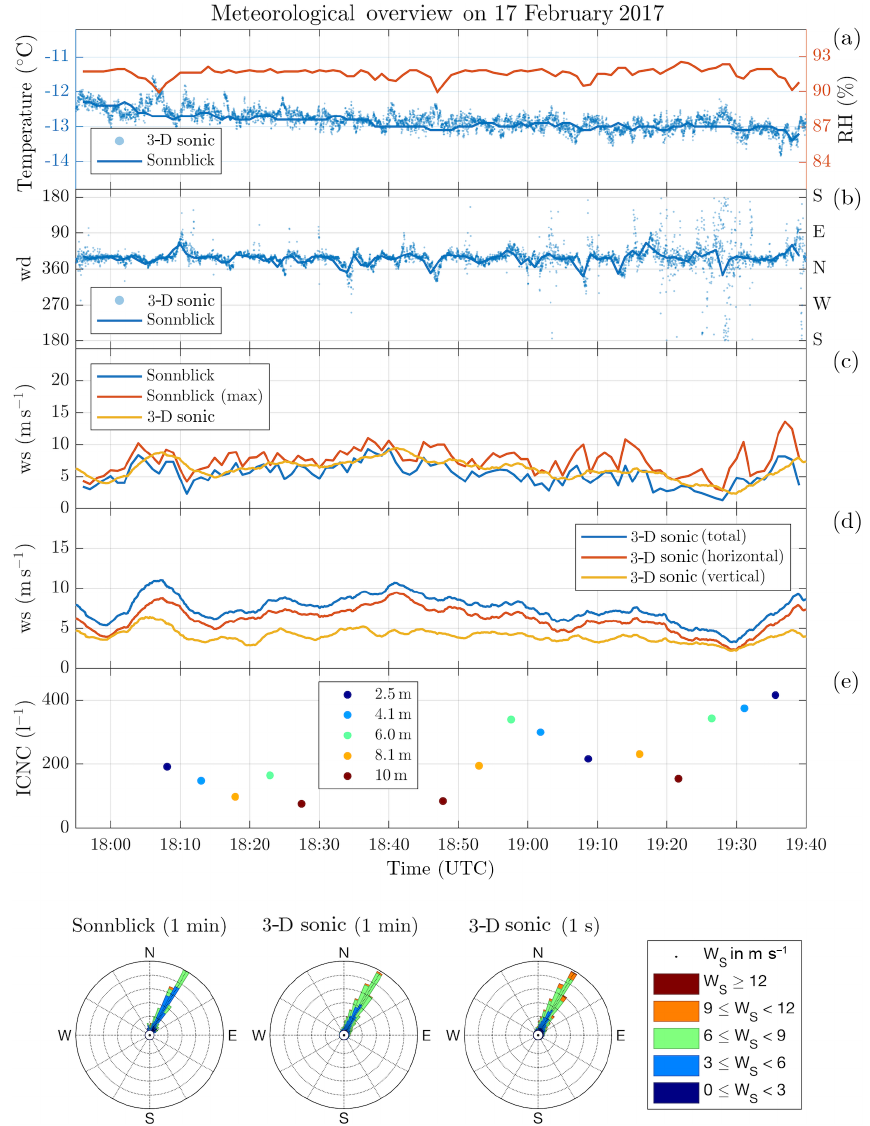
Figure 5. As Fig. 4, but for 17 February 2017. On this day temperature and wind measurements are available from the SBO and the 3-D sonic anemometer. Shown are the temperature and relative humidity (a) , wind direction (b) , a comparison of the horizontal wind speed from the SBO and the 3-D sonic anemometer (c) , and detailed wind speed from the 3-D sonic anemometer (d) and the ICNC (e)